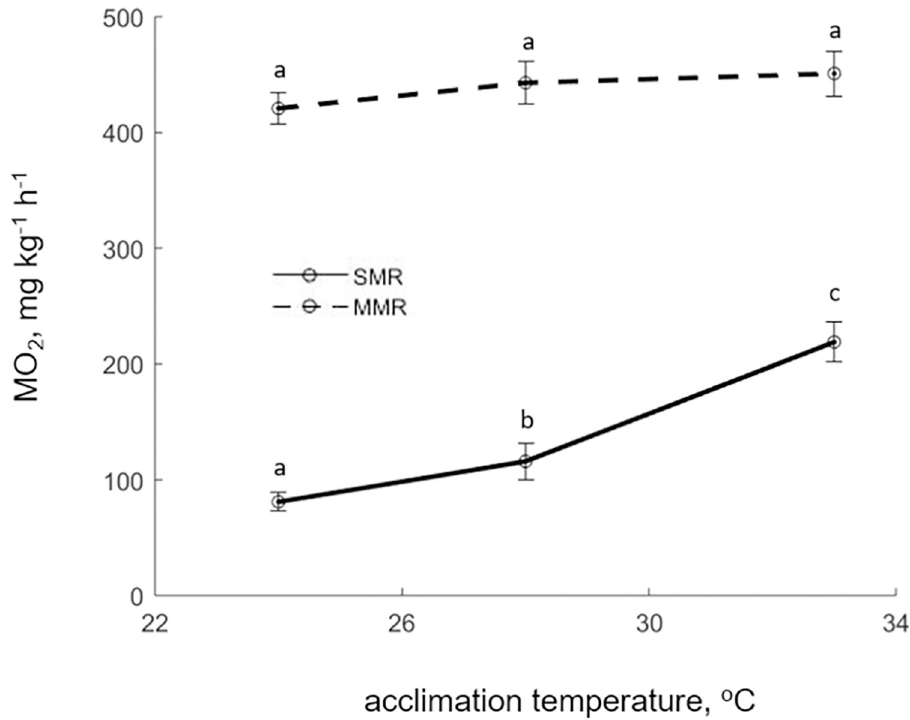
Fig 4. Standard and Maximum Metabolic Rate (SMR and MMR) of E. sea bass at different temperatures. Points represent replicate means and bars the SD (N = 15) and statistically significant differences between treatments are indicated with different